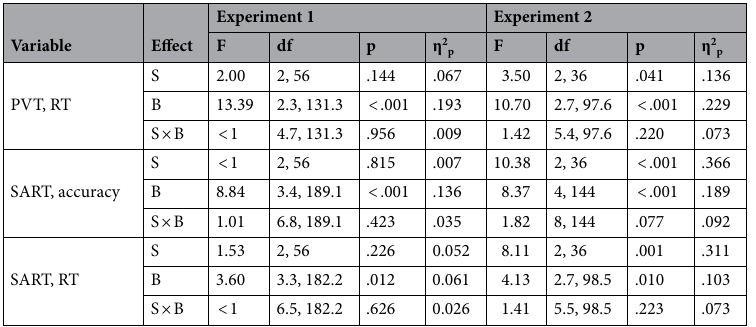
Table 1. Statistical results in Experiments 1 and 2 for the 3 (stimulation, S) × 5 (block, B) mixed ANOVAs on the RTs in the PVT, accuracy on no-go trials of the SART, and RTs on go trials of the SART. S stimulation, B block, the Greenhouse–Geisser sphericity correction was applied when